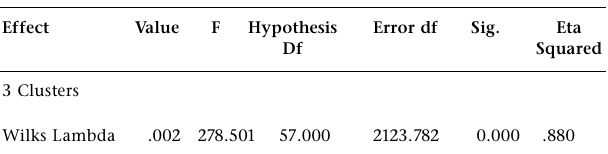
One-way ANOVA F